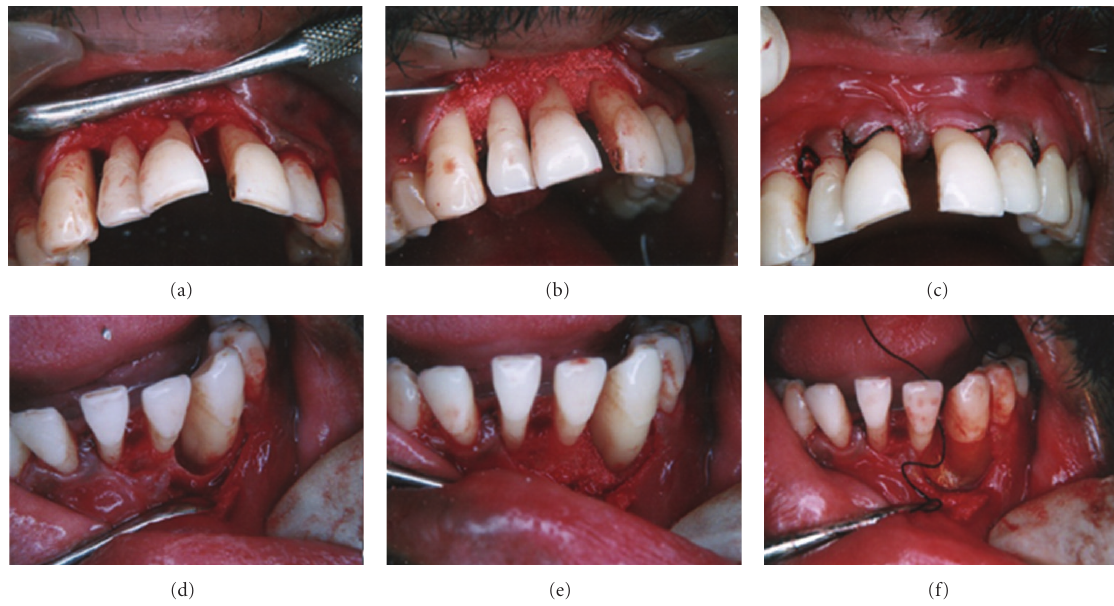
Figure 12: (a)–(c) Flap surgery in conjunction with bone grafting (HAP) and papilla preservation flap between 11 and 21. (d)–(f) Deep circumferential defect treated with bone grafting in conjunction with guided tissue regeneration.